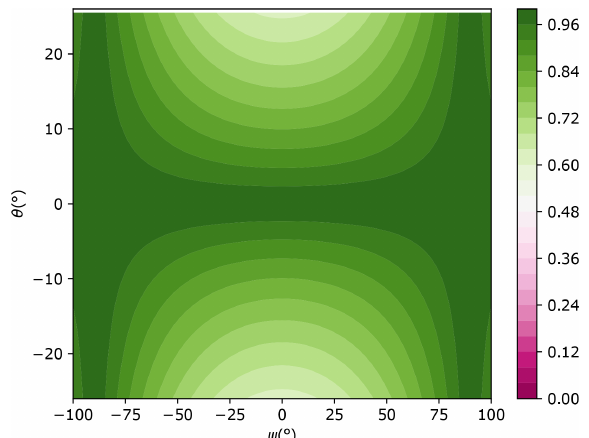
Figure 7. Dexterity distribution of the new haptic device in the plane ( ψ , θ